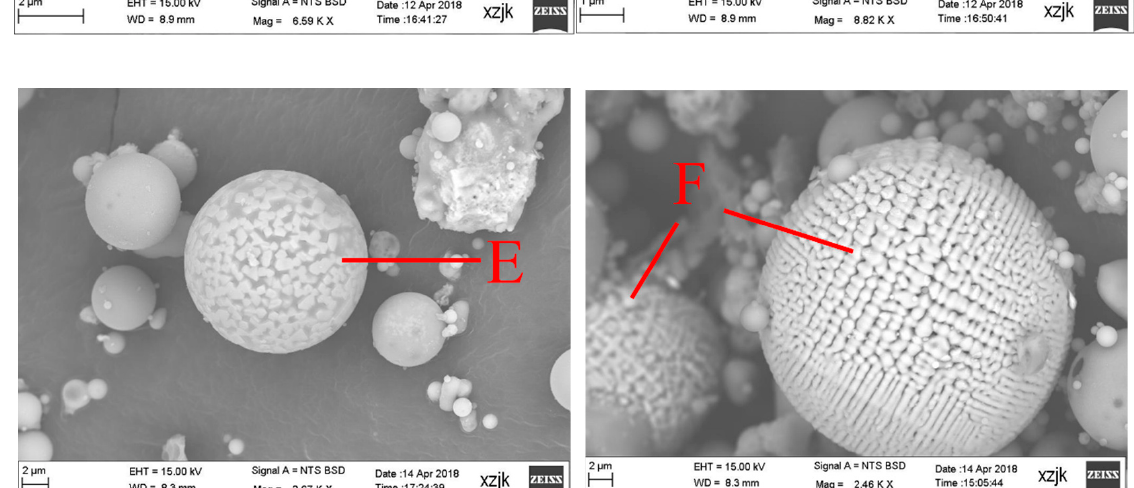
Figure 5. Results of SEM-EDS analysis for CA1 (A,B), CA2 (C,D), and CA3 (E,F). Table 3. The EDS analysis of points in Figure 5.